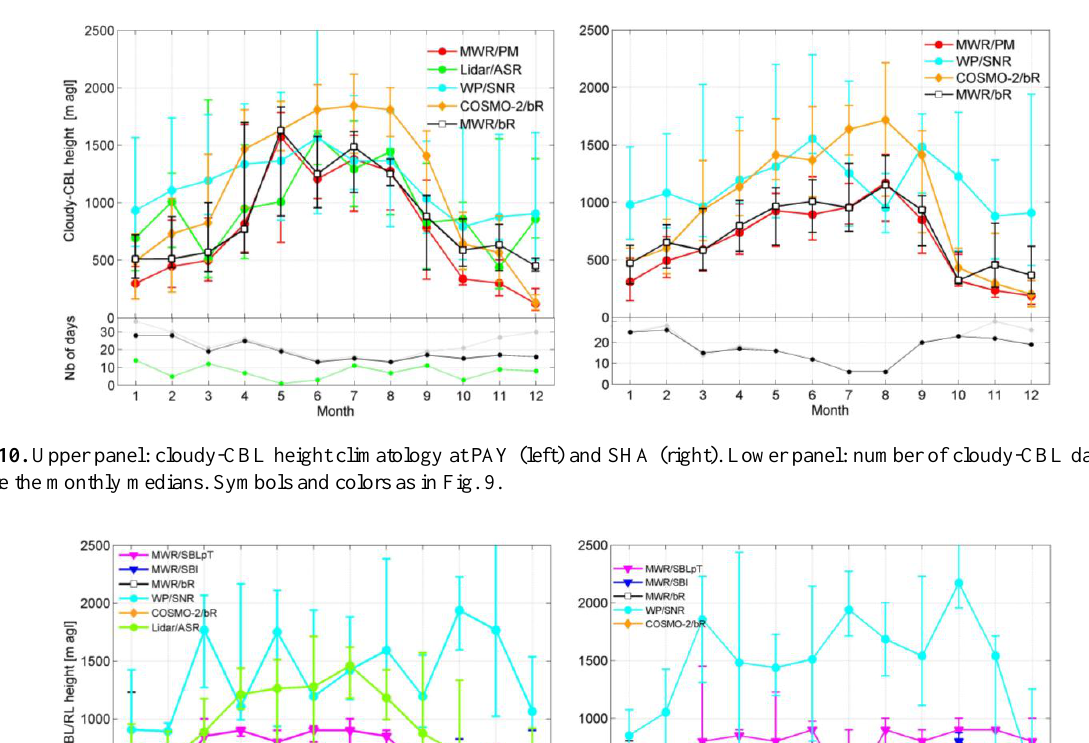
Figure 9: Upper panel: CBL height two-years climatology at PAY (left) and SHA (right). The symbols are the monthly median of the daily medians of the CBL height taken